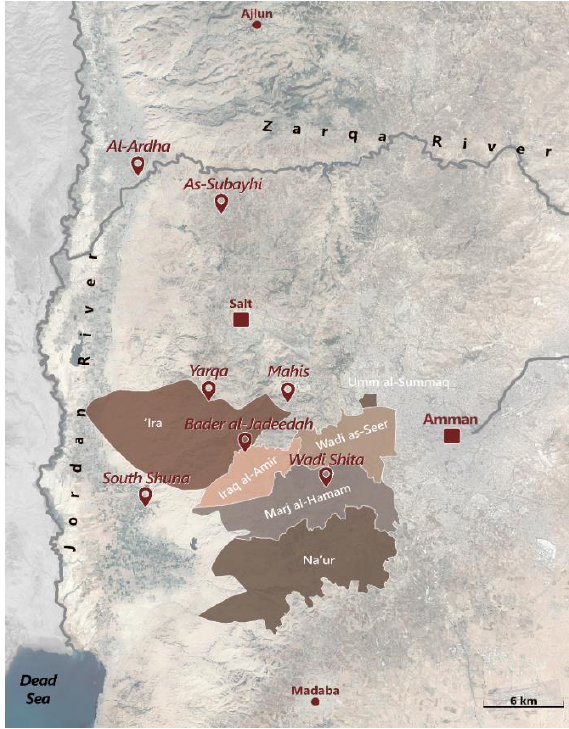
Figure 2. Reconstruction of the Bani ˁ Abb ā d dīra based on the information gathered during my fieldwork and realized by A. Cristaldi.